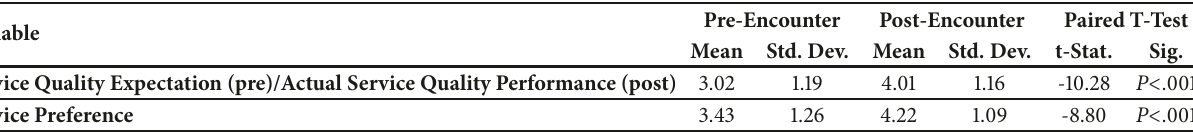
Figure 2: PLS analysis results. Table 4: Post hoc comparison of pre- and postbeliefs